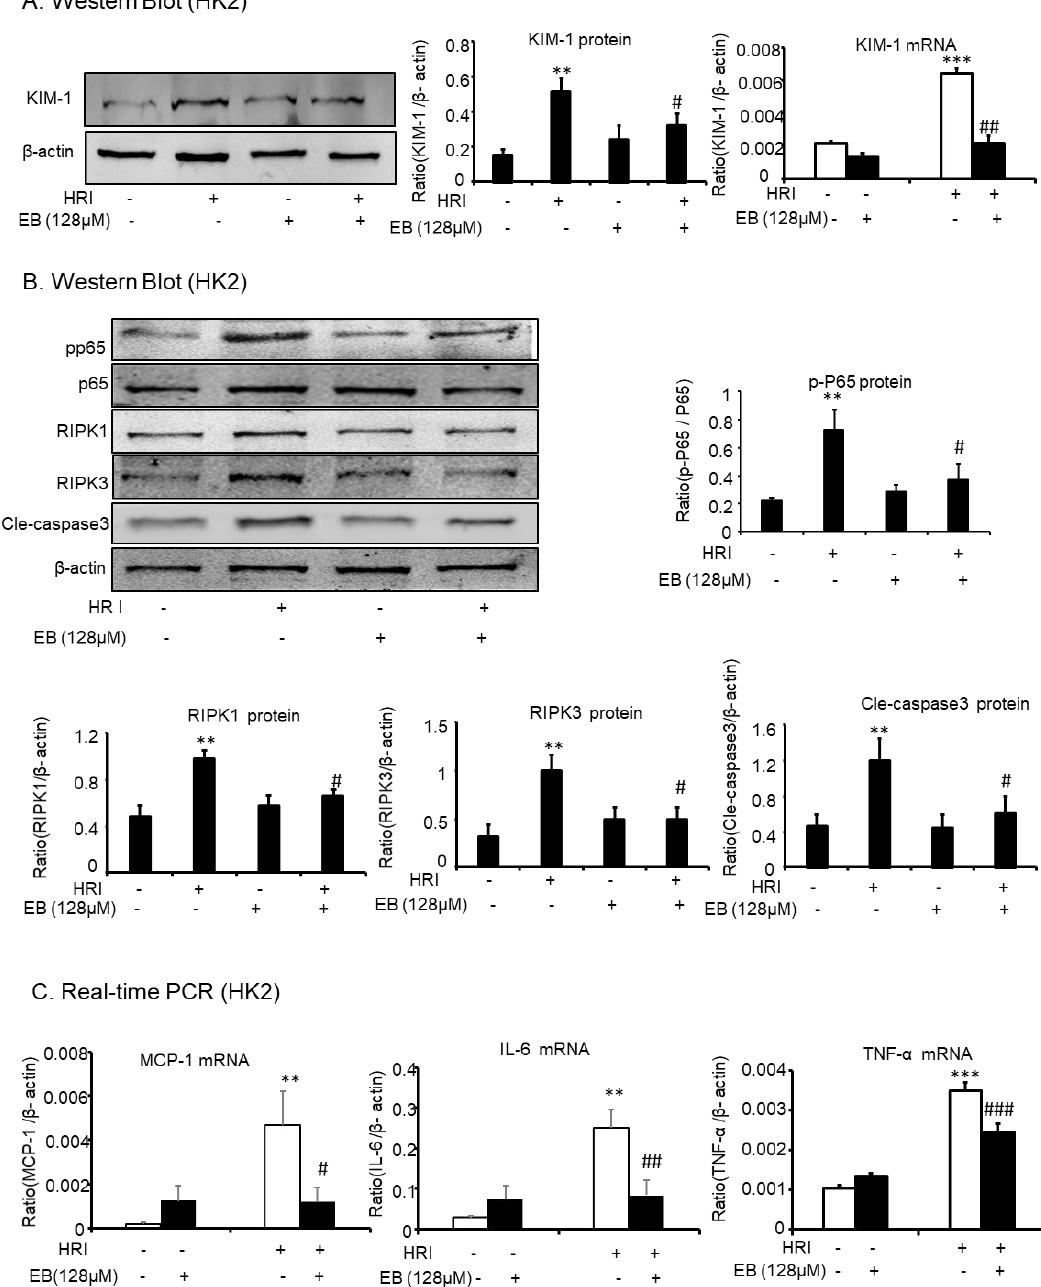
Figure 6. Eleutheroside B attenuated inflammation, programmed necrosis, and apoptosis in HR-induced HK-2 cells. ( A ) Western blot and real-time PCR analysis of KIM-1. ( B ) Western blot analysis of RIPK1, RIPK3, p-P65, and cle-caspase-3 in HR-induced HK-2 cells. Western blot result and quantitative data indicate that treatment of eleutheroside B reduced the percentage of KIM-1, RIPK1, RIPK3, p-P65, and cle-caspase-3 cells in HR-induced HK-2 cells. ( C ) Real-time PCR in HK-2 cells. Results demonstrate that eleutheroside B largely reduced HR-induced mRNA levels of TNF- α, MCP-1, and IL-6. Data represent the mean ± SEM for 3 – 4 independent experiments. * p < 0.05, ** p < 0.01, *** p < 0.001 compared with control; # p < 0.05, ## p < 0.01, ### p < 0.001 compared with cisplatin-treated group. HRI, hypoxia-reoxygenation injury; EB, eleutheroside B.